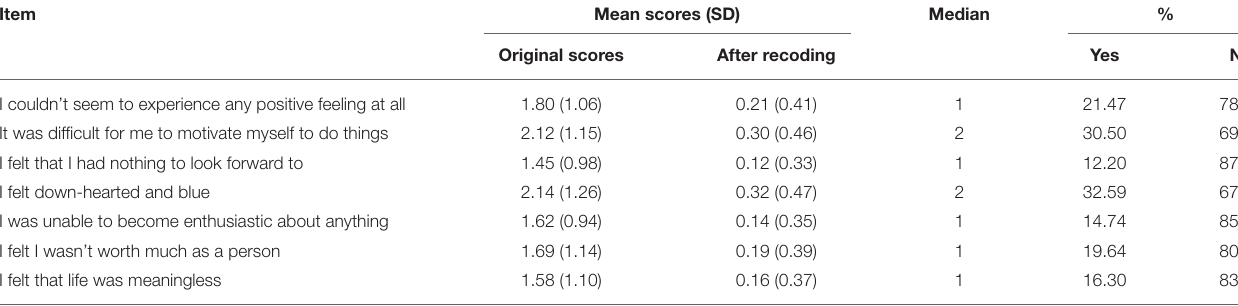
TABLE 4 | Descriptive scores of depressive symptoms (raw and dichotomized scores).